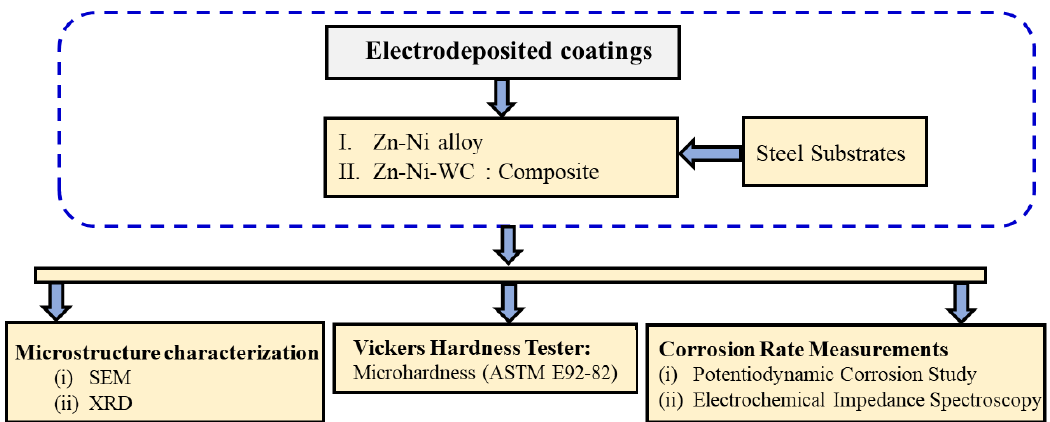
Figure 2. Flowchart of characterization and testing of electrodeposited coatings.